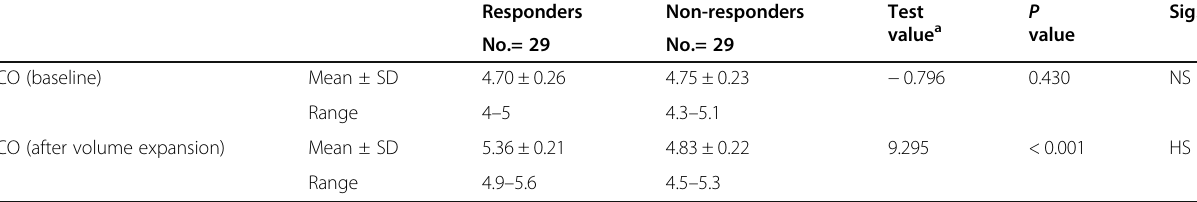
Table 3 Comparison between responders and non-responders regarding cardiac output (CO) values of the studied patients